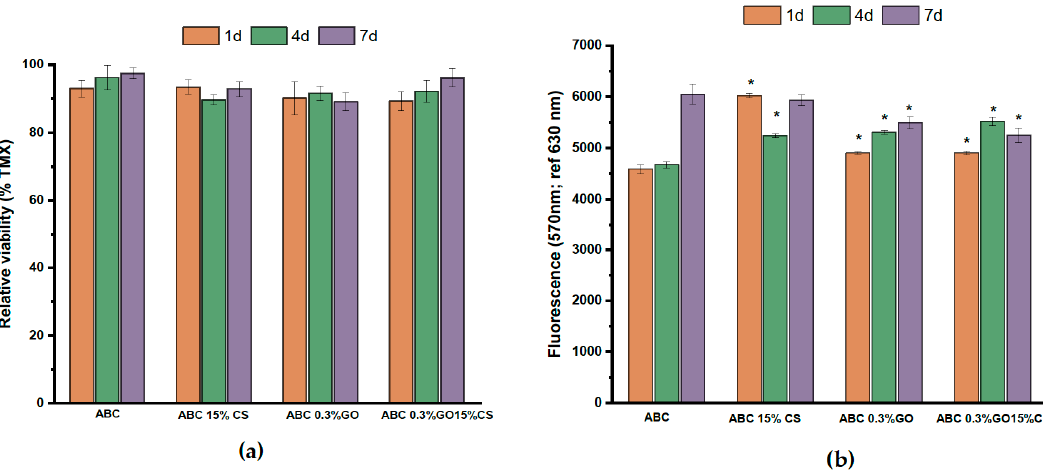
Figure 9. ( a ) Cell viability of human osteoblasts in the presence of extracts of ABCs taken after 1, 4, and 7 days; ( b ) Direct Alamar Blue results for control ABC and modified ABCs over a period of 1, 4, and 7 days. Results are the mean ± SD. Statistical analysis ( n = 12) for each group was performed comparing experimental ABCs samples respect to ABC group at a significance level of p < 0.01.